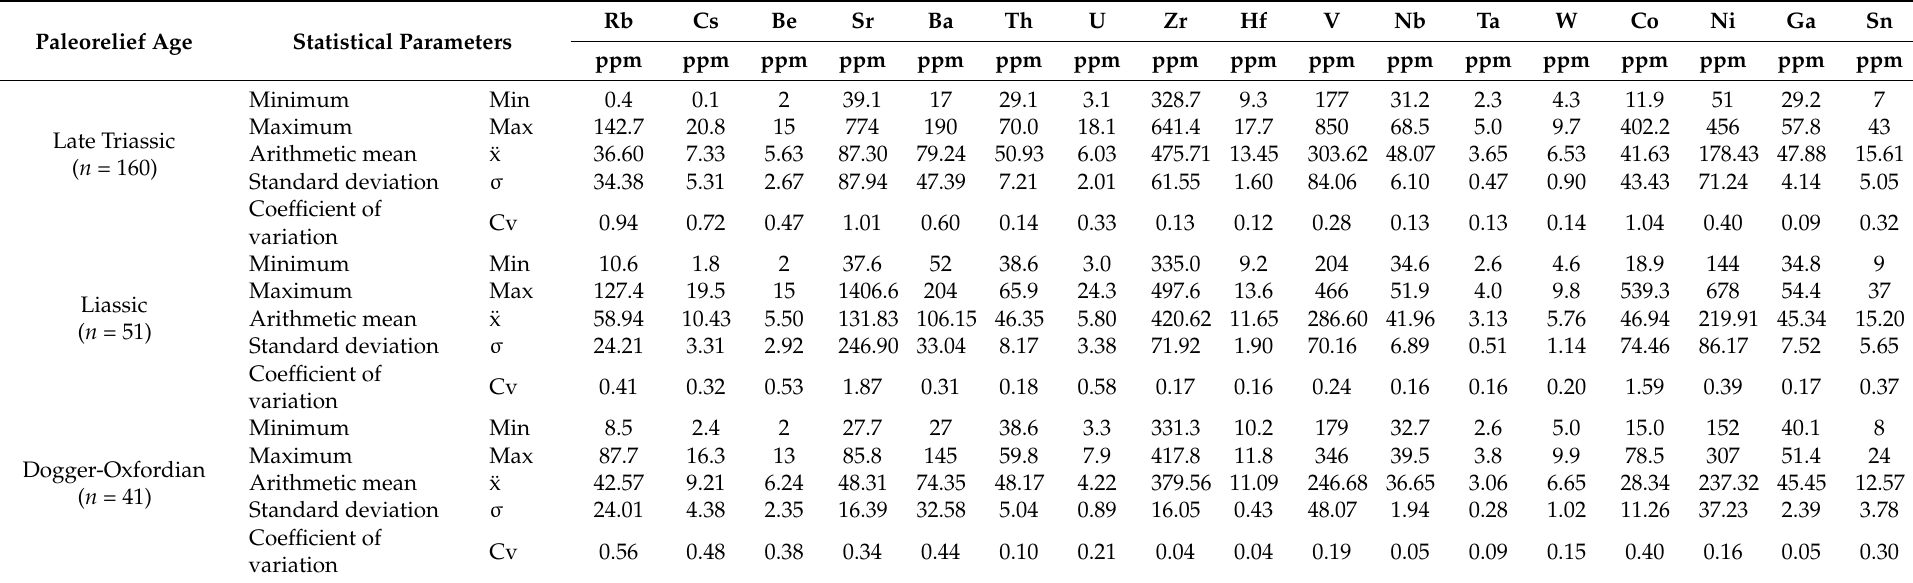
Table 10. Statistical parameters of geochemical analyses of trace elements in Jurassic bauxites of the Vojnik-Maganik and Prekornica ore regions (after Radusinovi´c [5]). Rb Paleorelief Age Statistical Parameters